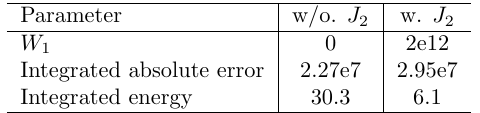
Table 3: Results with and without energy